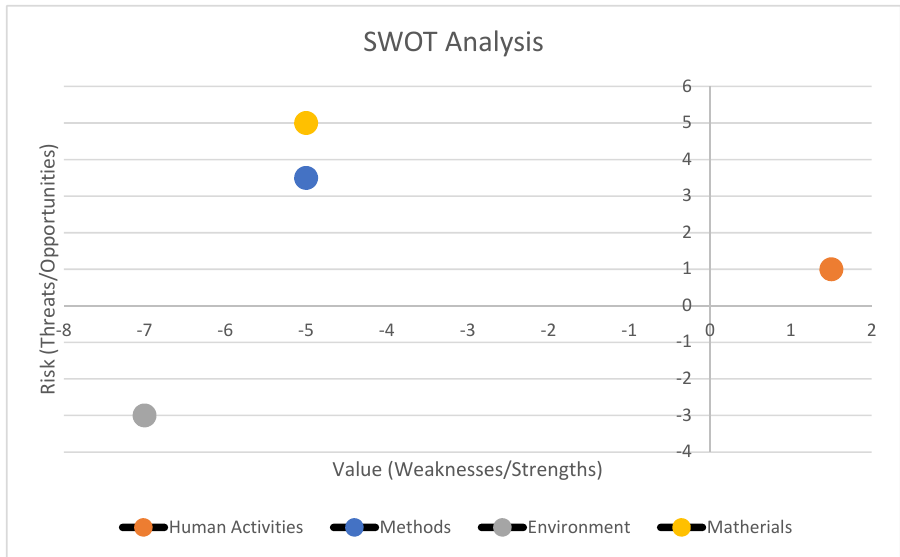
Figure 3. Plot graph of SWOT analysis. Comfort Zone: upper left. Danger Zone: lower right. Challenge Area: lower left. Improvement Area: upper right. The score is given on the abscissa, by the pros/cons ratio, and on the ordinate by the potential risk/perceived